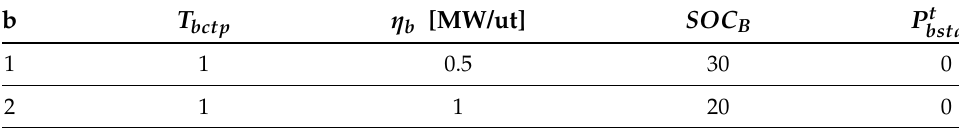
Figure 7. Renewable resources output power data. Table 5. Parameters of BESS.